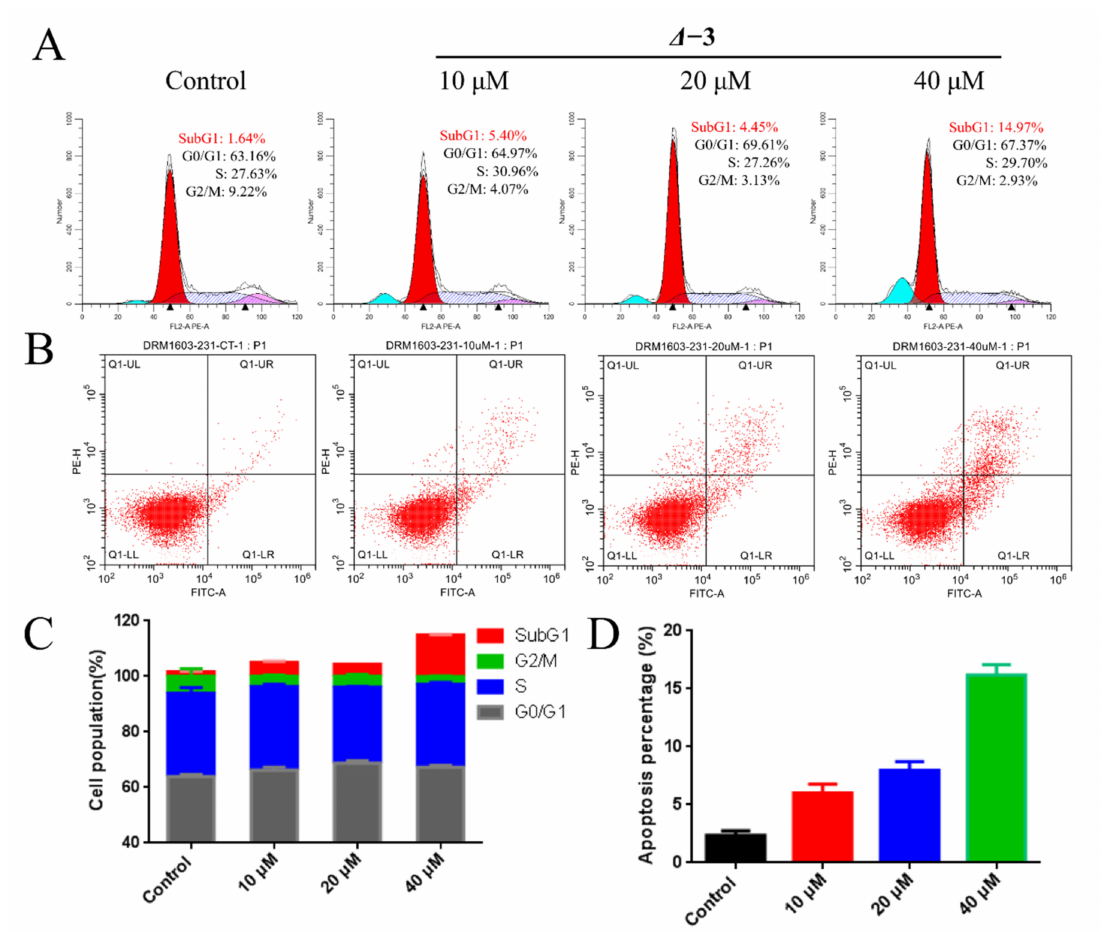
Figure 7. The apoptosis induction of ∆ − 3 in MDA-MB-231 cells. ( A ) Cell cycle distribution of MDA-MB-231 cells after treatment with ∆ − 3 at different concentrations (0, 10, 20, and 40 µ M) for 72 h was detected by flow cytometry. ( B ) Apoptotic rate of MDA-MB-231 cells was measured by flow cytometry after treatment with ∆ − 3 (0, 10, 20, and 40 µ M) for 72 h. ( C ) Graphical representation of cell-cycle distribution of MDA-MB-231 cells after treatment with ∆ − 3 . ( D ) Percentage of the apoptosis in the ∆ − 3 -treated MDA-MB-231